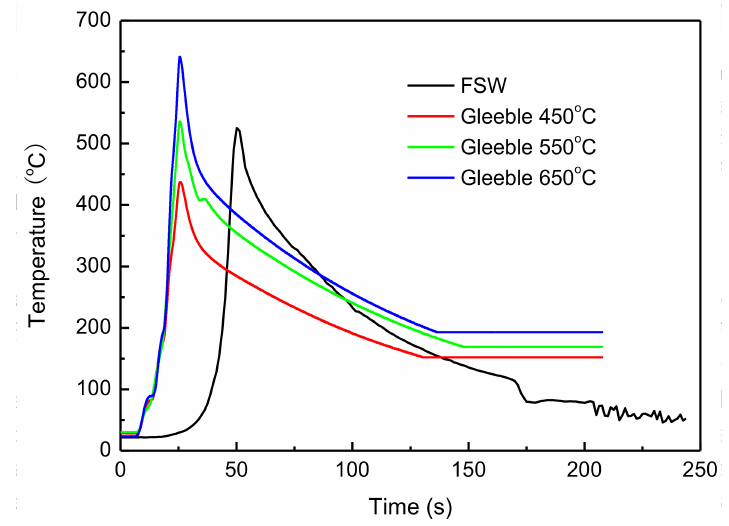
Figure 3. Temperature variation of the HAZ in the FSW joint and the welding thermal simulation